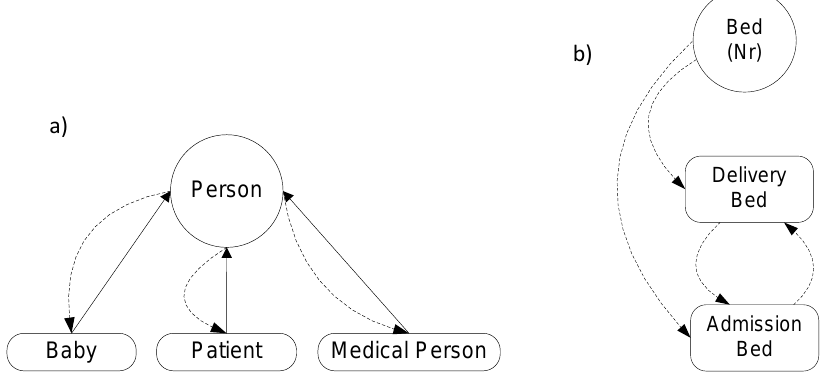
Figure 7. ORM sub-scheme for object types Person (a) and Bed(b)